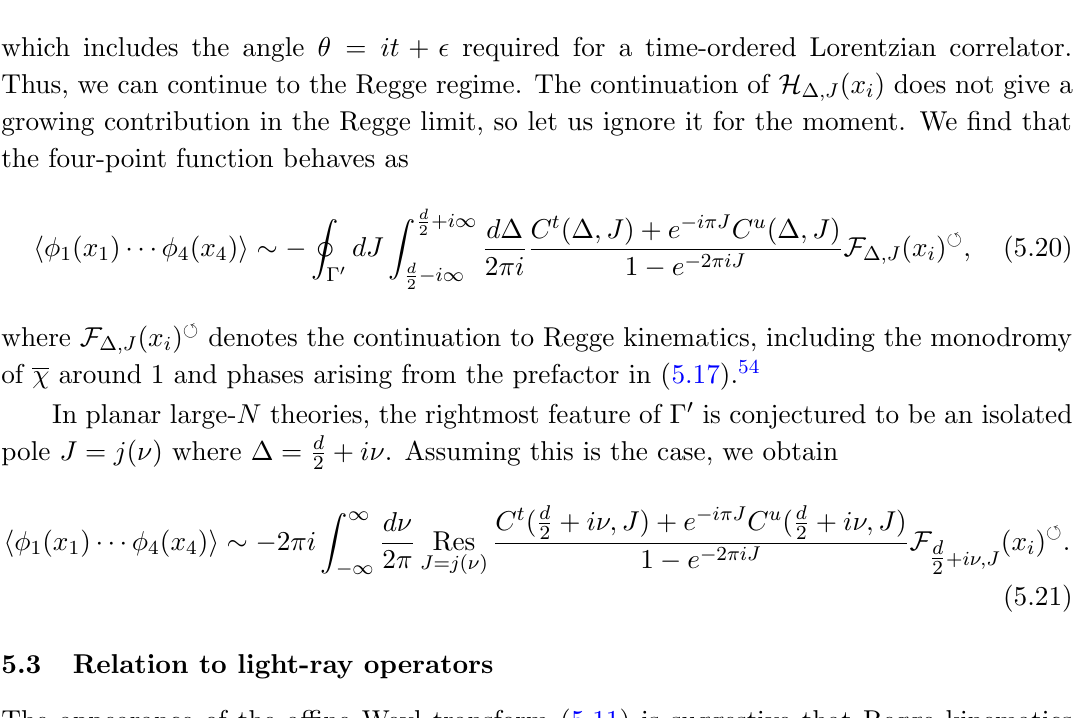
Figure 14. Integration contours in the J plane. The contour (cid:0) (blue) encircles all the integers clockwise. The deformed contour (cid:0) 0 runs parallel to the imaginary axis, asymptotically approaching Re( J ) = (cid:0) d (cid:0) 2 at large imaginary J . In deforming the contour, we must ensure that (cid:0) 0 avoids non- 2 analyticities, like a pole at non-integer J , branch cuts, or other singularities. Here, we show a single non-integer pole at J = j ( (cid:23) ) and possible non-analyticities in the shaded region. However, this is only an example | we don’t know the structure of the J -plane in